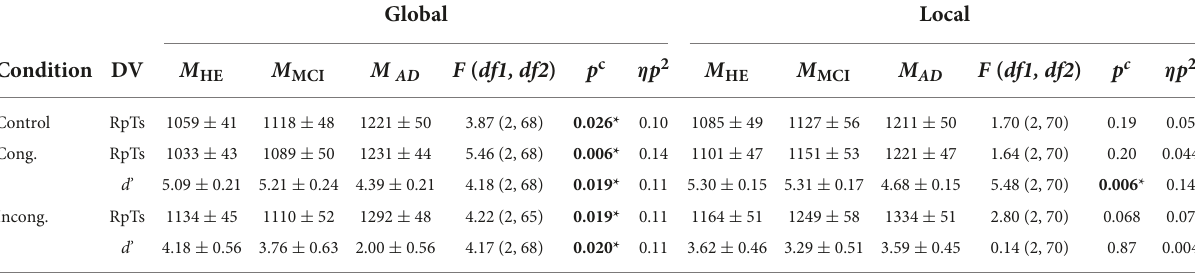
TABLE 3 Estimated mean values and statistical results of Group × Task × Congruency comparing mean RpTs and d’ between Groups. Global Local Condition DV